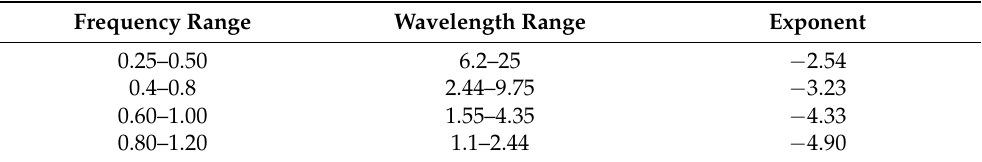
Figure 6. Panorama of the wave spectra. Power-law approximation exponents in different parts of the one-dimensional (integral) spectrum: ( a ) for 0.25–0.50 Hz; ( b ) for 0.4–0.8 Hz; ( c ) for 0.6–1.0 Hz; ( d ) for 0.8–1.2 Hz. The coefficients are shown at the locations of the original fragments of the satellite image. Table 1. Spatially averaged coefficients of the power-law decay of the spectra for different frequency ranges.